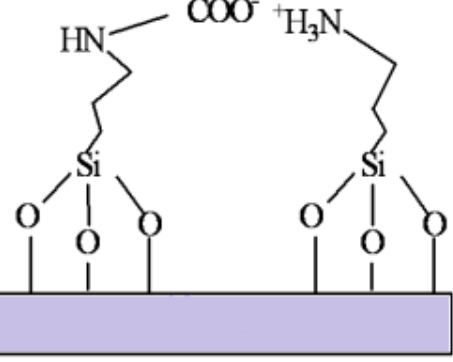
Figure 6. Mechanism proposed for the CO 2 adsorption in clay minerals grafted with APTES.